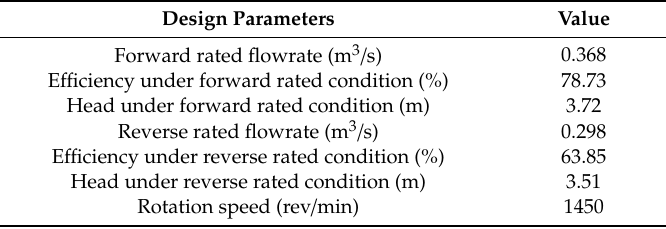
Table 9. The main design parameters of the optimized reversible axial-flow